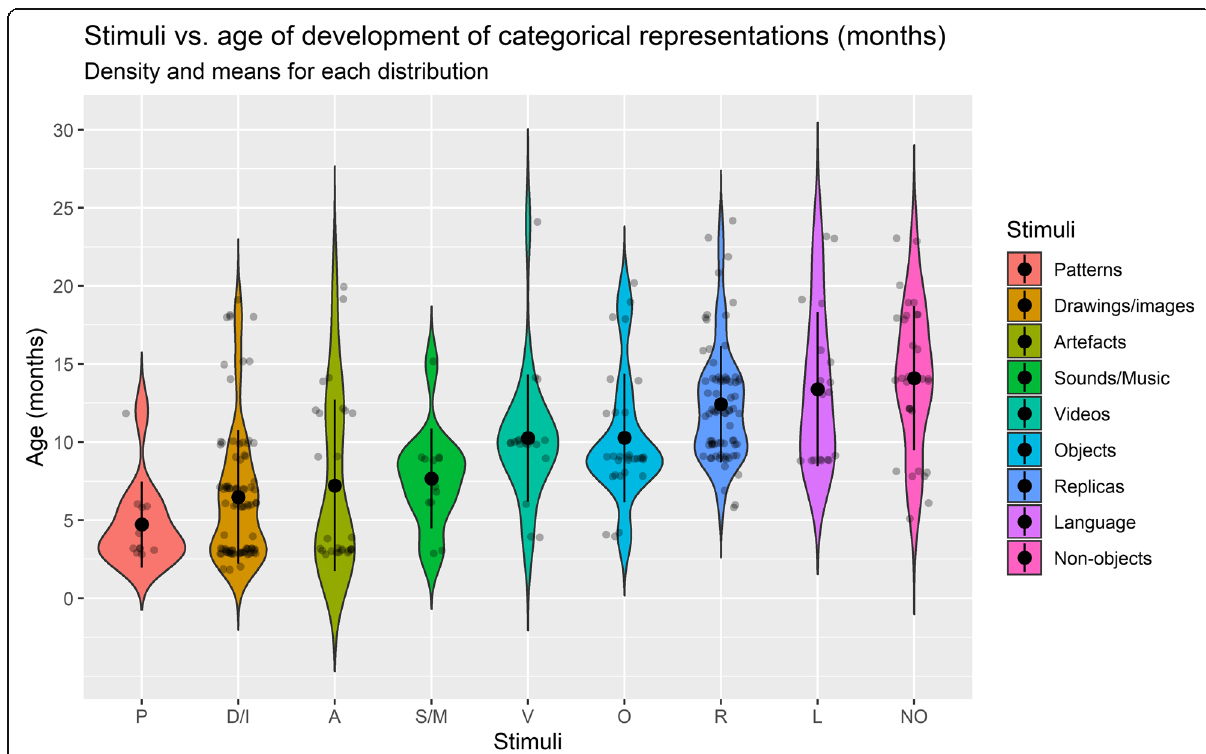
Fig. 6 Stimuli vs age of development of categorical representations (months). Density and means for each